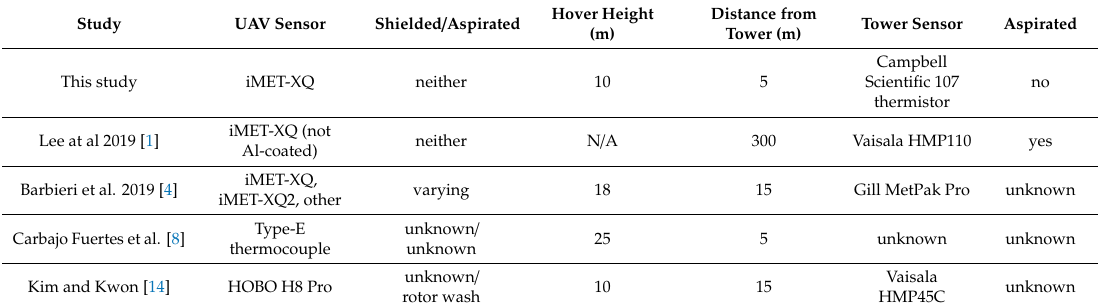
Table 1. Details of the tower versus the unmanned aerial vehicle (UAV) temperature measurement comparison experiments conducted in past studies. Al-coated stands for aluminum coated. Hover height is given in meters above ground level.